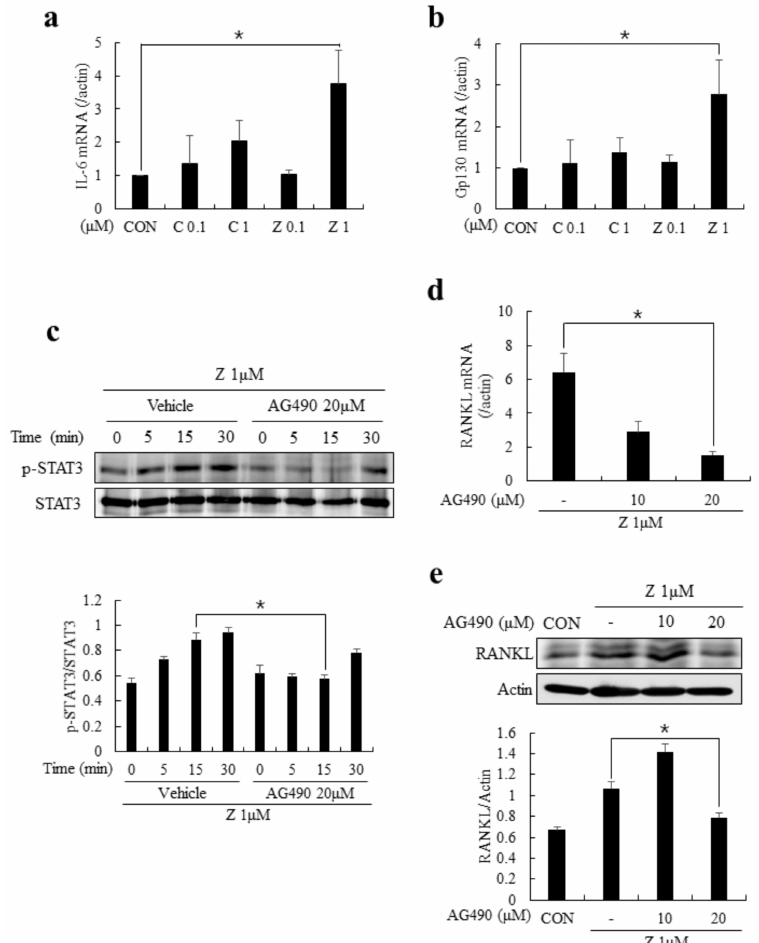
Figure 4. Zoledronate enhanced the RANKL expression via interleukin-6 (IL-6)/Janus activated kinase (JAK2)/ signal transducer and activator of transcription 3 (STAT3) pathway in MLO-Y4 cells. ( a , b ) MLO-Y4 cells were cultured in the presence of indicated doses of clodronate (C; 0.1 or 1 µ M) or zoledronate (Z; 0.1 or 1 µ M) for 2 days and the mRNA expressions of IL-6 and gp130 were examined by quantitative real-time PCR; ( c ) MLO-Y4 cells were cultured in the medium containing zoledronate (1 µ M) for 2 days and serum-starved for 5 h. The cells were pretreated with vehicle (DMSO) or AG490 (20 µ M) for another 1 h and re-stimulated with zoledronate. The phosphorylation of STAT3 was evaluated by immunoblotting (upper). The relative band intensity of p-STAT3 was normalized by STAT3 with densitometry and the quantitative results are shown as graphs (lower); ( d , e ) MLO-Y4 cells were cultured in the presence of zoledronate (1 µ M) together with AG490 (0, 10, and 20 µ M) for 2 days. After the culture, the expression of RANKL was determined by quantitative real-time PCR ( d ) or immunoblotting ( e ). Quantitative data are presented as mean ± SD (* p <